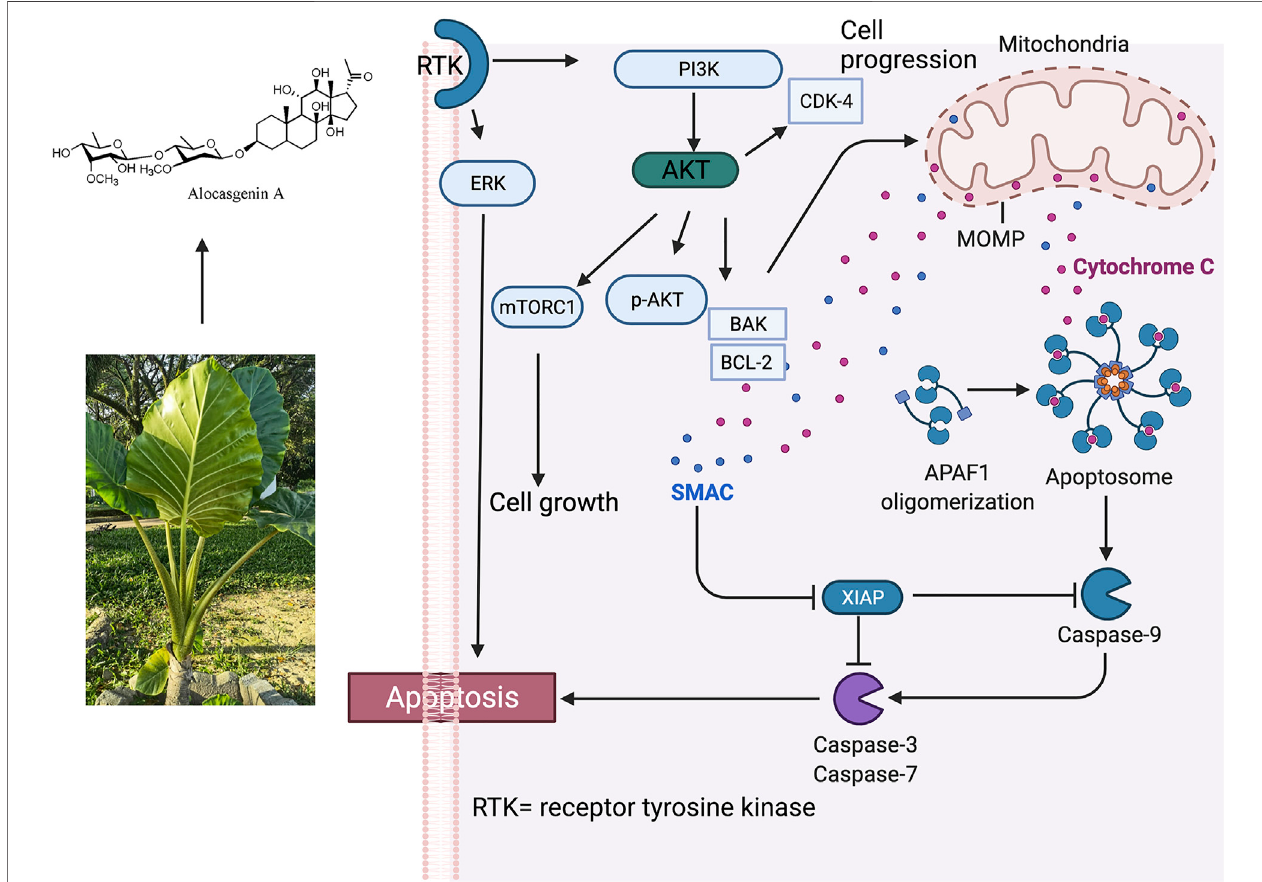
FIGURE 3 | Proposed antitumor activity of Alocasia via intrinsic apoptosis. Phosphorylation of Bax by Akt or activated Akt disables its translocation to the mitochondrial membrane, then decreases permeabilization. p-AKT was signi fi cantly decreased in a dose-dependent manner, while the treatment did not change AKT expression.Itwasalso foundthattheexpressionofBcl-2protein decreasedandtheexpression ofBaxproteinincreasedwhichledtoanincrease oftheBax/Bcl-2 ratio. It was postulated that Alocasia works via following mechanism: 1) PI-3 K/Akt pathway of apoptosis; 2) ERK activity of apoptosis; 3) triggering of mitochondrial pathway; 4) connection by Bcl-2 and Bax; v.G0/G1 cell cycle arrest (Wei, et al., 2015). Alocasgenin A represents anticancer compound from Alocasia